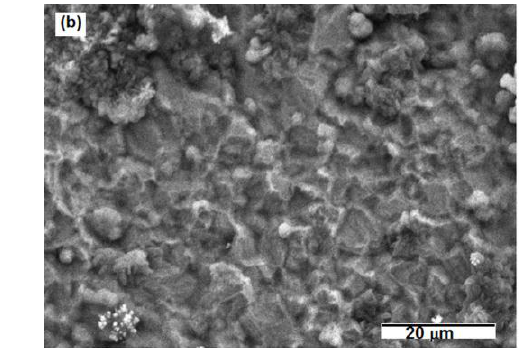
Figure 3. Characteristic EDS (energy dispersive spectrometry) spectra of gold samples after two hours time of magnesium underpotential deposition from: ( a ) magnesium/ammonium nitrate